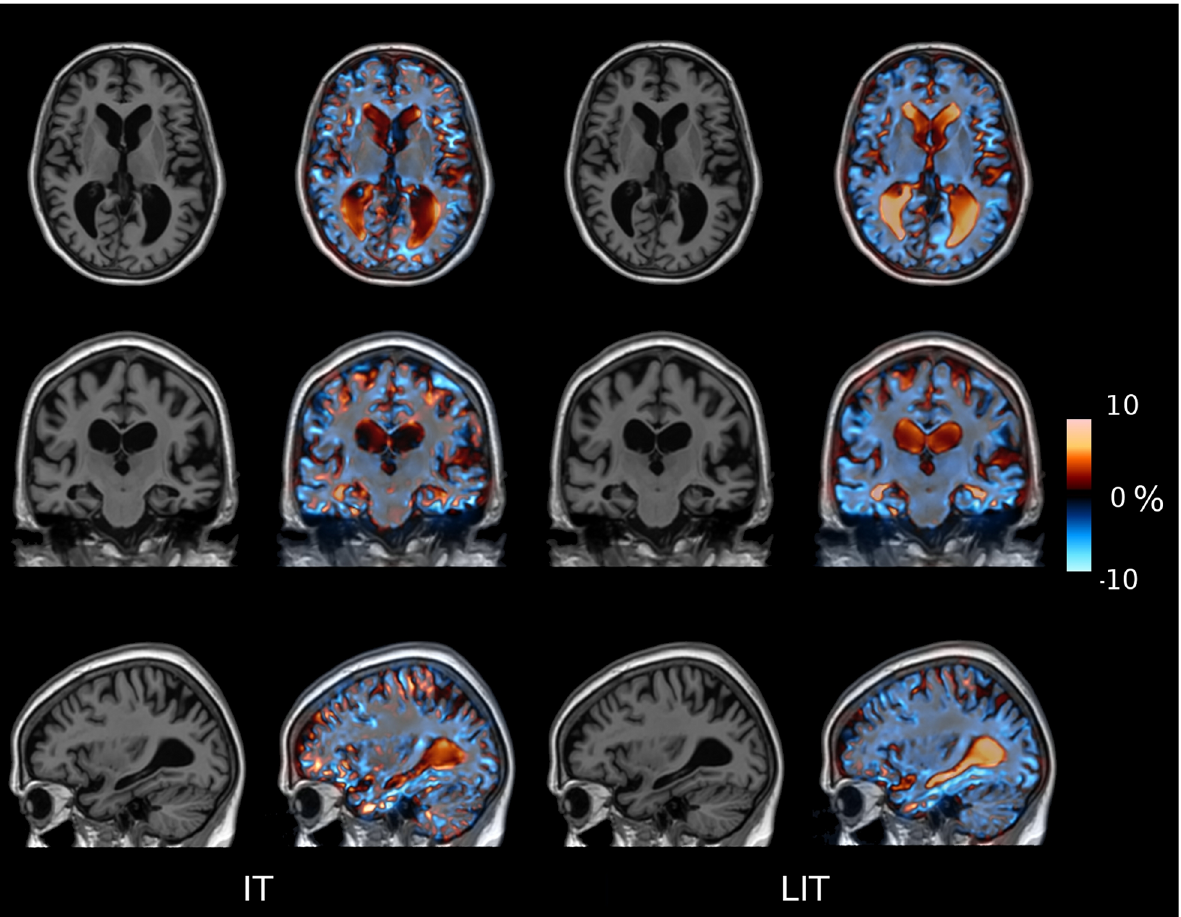
Fig 7. Longitudinal deformation fields. Deformation fields from baseline to the 12 month time-point for the longitudinal approaches (IT and LIT) where red represent growth and blue atrophy for a randomly chosen AD subject.